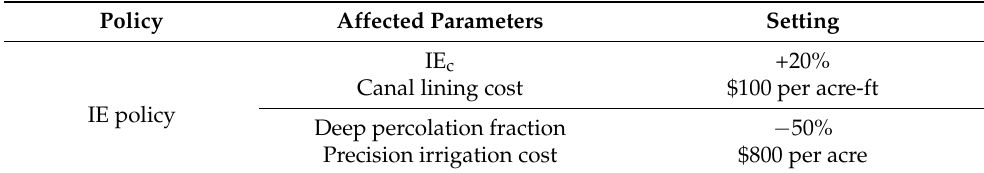
Table 2. Variables setting for IE